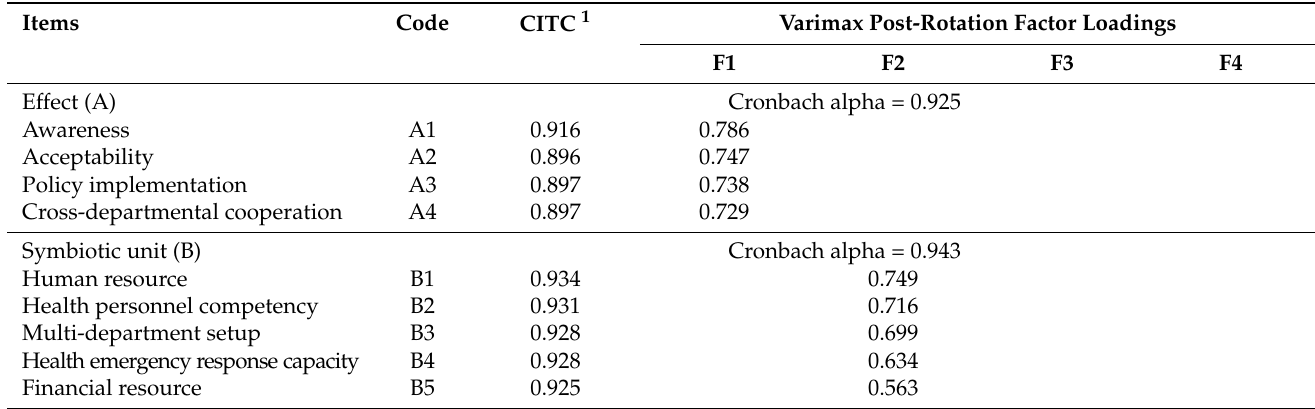
Table 3. Reliability test of variable